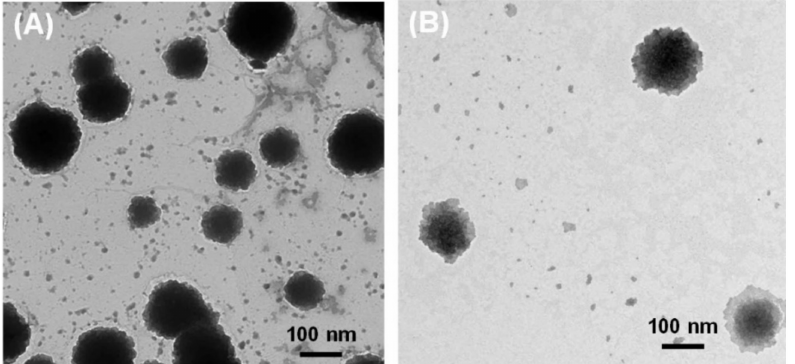
Figure 3. Transmission electron microscopy images of the elastic liposomes: ( A ) SGDC-EL and ( B ) SC-EL.